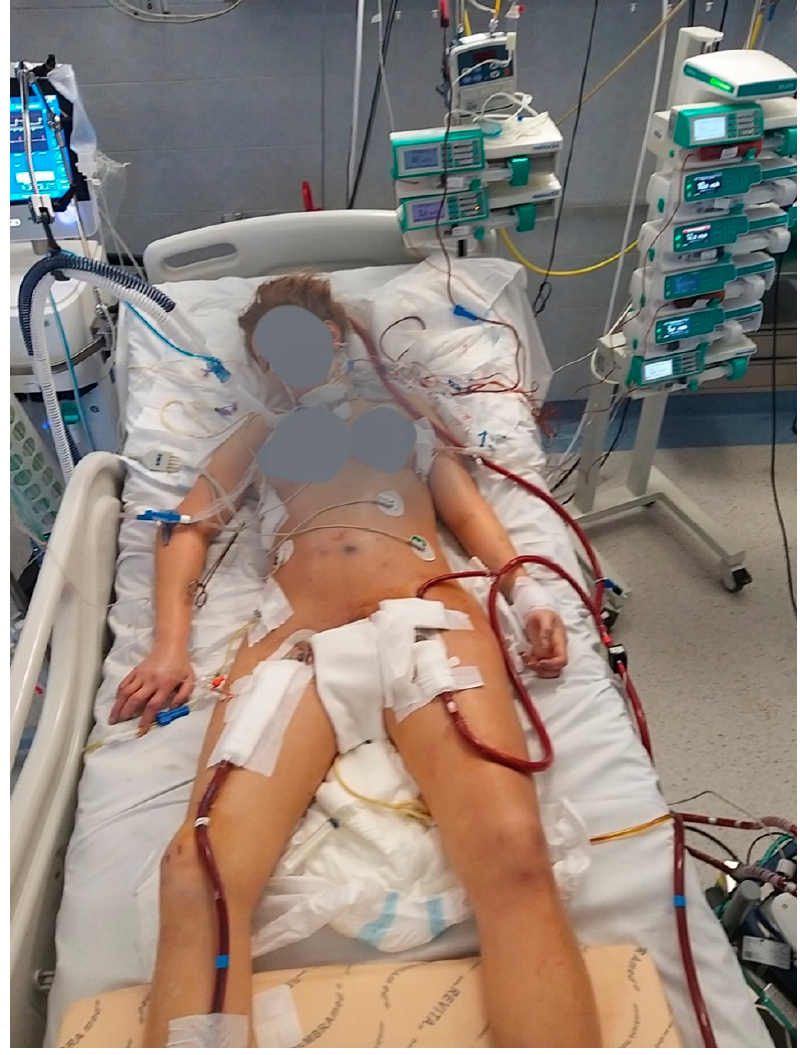
Figure 3. Hybrid ECMO setting for COVID ‐ 19 ARRF. V ‐ VA (+) configuration: venous drainage femoral cannula, venous inflow jugular cannula, arterial femoral cannula and (+): femoral distal perfusion cannula.